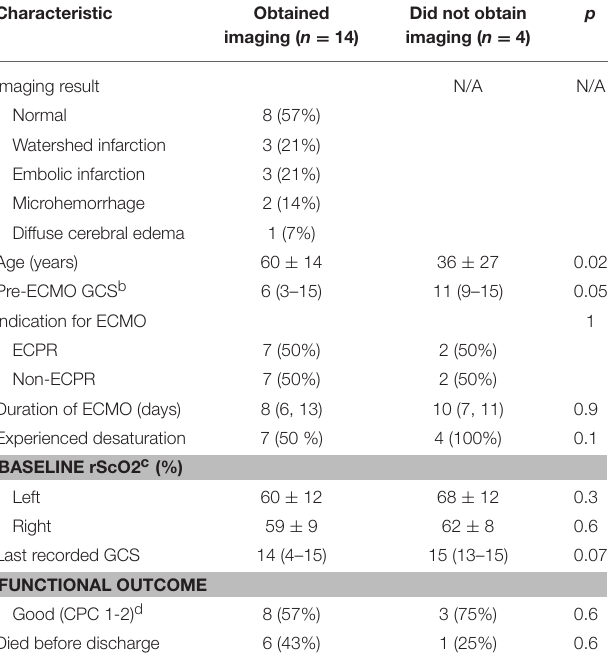
TABLE 3 | Characteristics of groups with and without